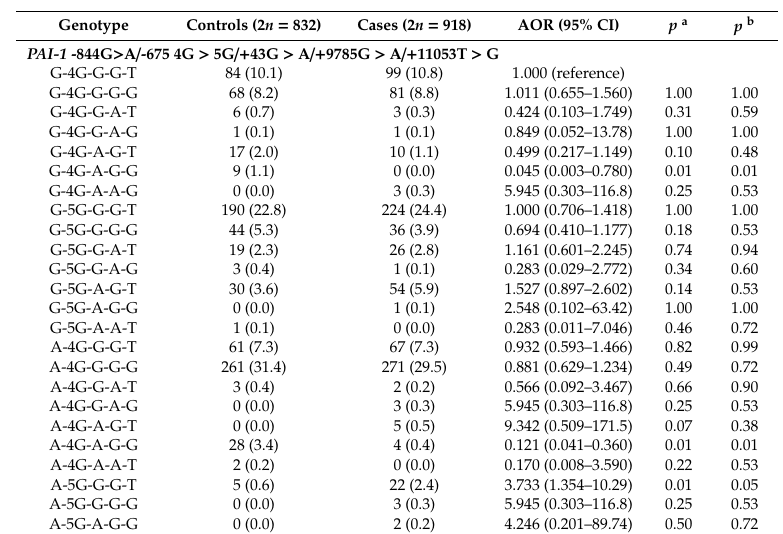
Table 4. Haplotype analysis of the PAI-1 gene polymorphisms on colorectal cancer risk.